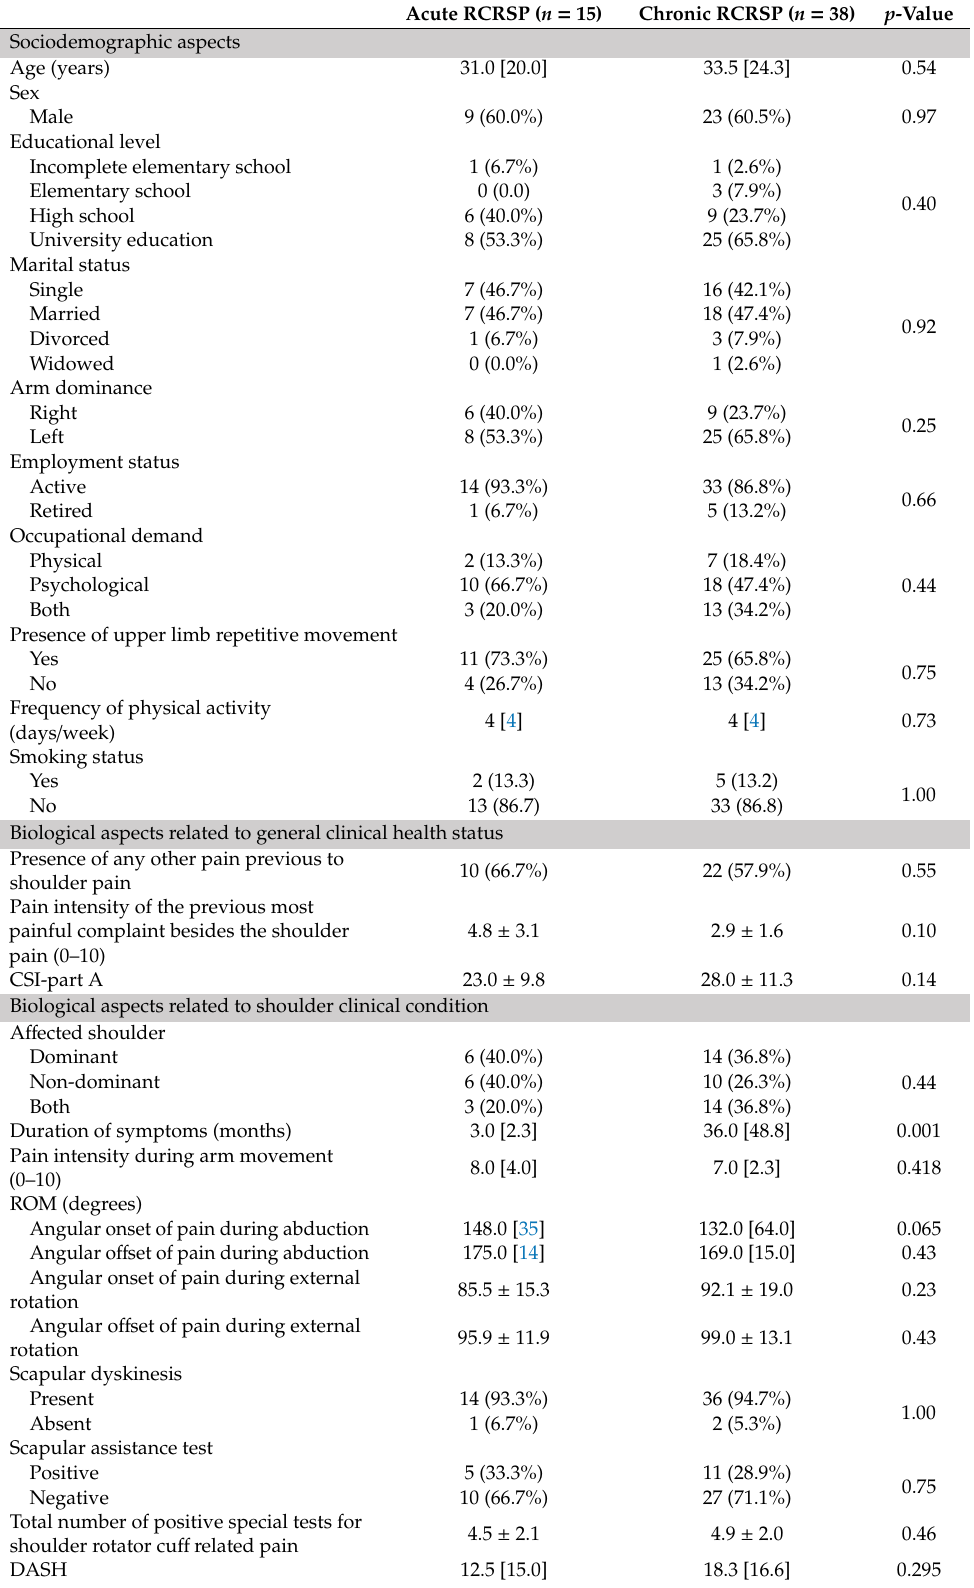
Table 1. Characteristics of the participants related to sociodemographic and clinical